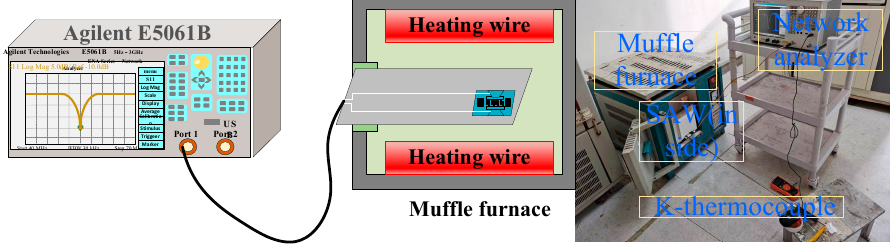
Figure 3. High temperature test system, real-time access to the S11 performance of SAW devices in temperature experiments.